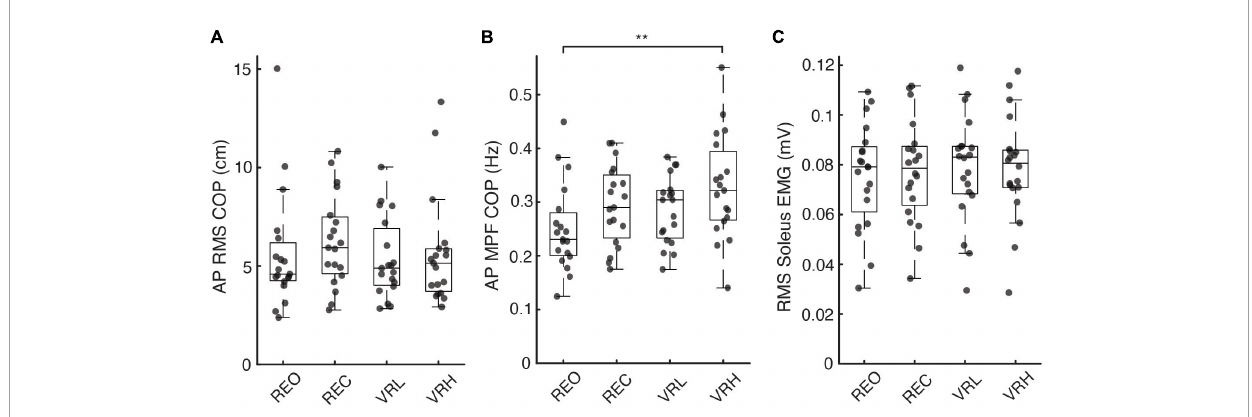
FIGURE3 Postural sway and soleus muscle activity across real and virtual conditions. (A) Root-mean-squared (RMS) amplitude and (B) mean power frequency of anteroposterior (AP) centre of pressure (COP) excursions, as well as (C) RMS soleus muscle activity, across each visual condition. Asterisks denote significance at the p < 0.01**